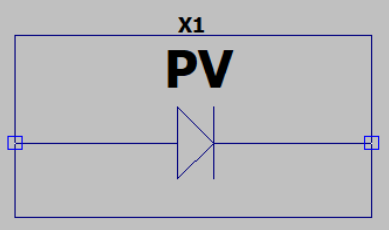
Figure 17. An example of how a custom symbol may be used to represent a sub-circuit (in this case, the FCPVM from Figure 15). Developed from [18].